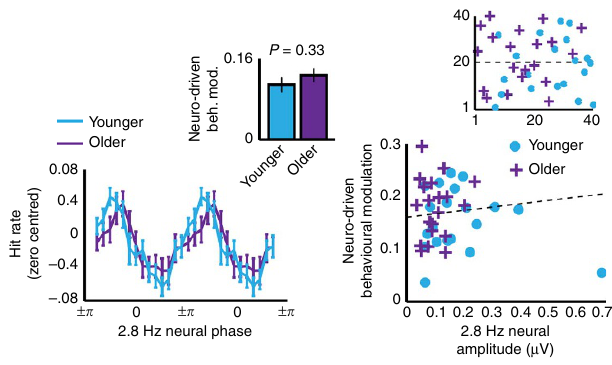
Figure 5 | Gap-detection is modulated by pre-gap neural phase. Left: Neuro-driven behavioural modulation: hit rates (shown zero-centred) were modulated by 2.8Hz neural phase with a similar magnitude (neuro-driven behavioural modulation, that is, hit rate peak-trough) for younger and older participants (inset). Error bars show s.e.m. Right: Neuro-driven behavioural modulation was not correlated with entrainment strength. Best-fit line shown ignoring outlying data point (from the younger group). Inset plots ranks on which Spearman correlation was based. Ranks on 2.8Hz amplitude is plotted on x axis and ranks on neuro-driven behavioural modulation are plotted on y entrained neural responses (active versus passive) using separate Wilcoxon sign-rank tests for each model parameter (FDR- corrected across parameters), all p FDR X 0.25, all r o 0.18 ( n ¼ 40).